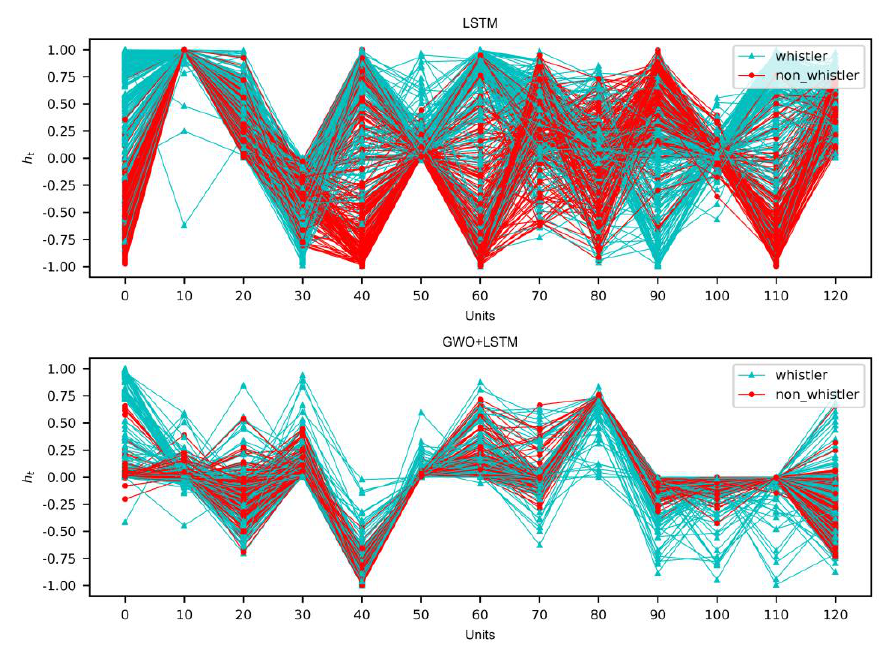
Figure 6. Hidden layer ℎ 𝑡 state information feature diagram.